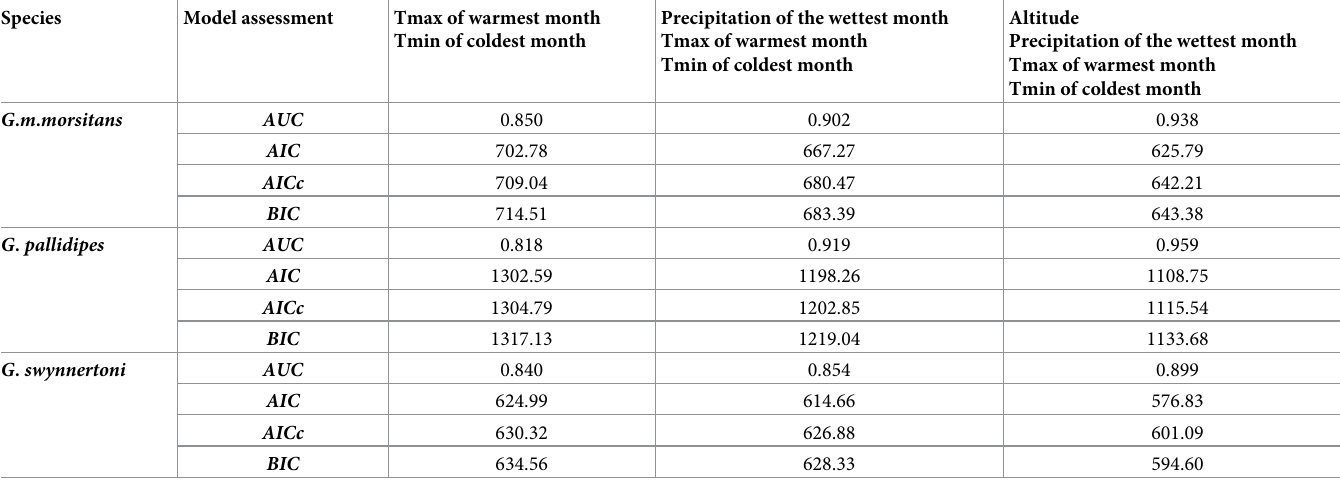
Table 2. Model performance based on AUC, AIC, AICc and BIC values for tsetse fly species occurrence and different combinations of the environmental variables. Species Model